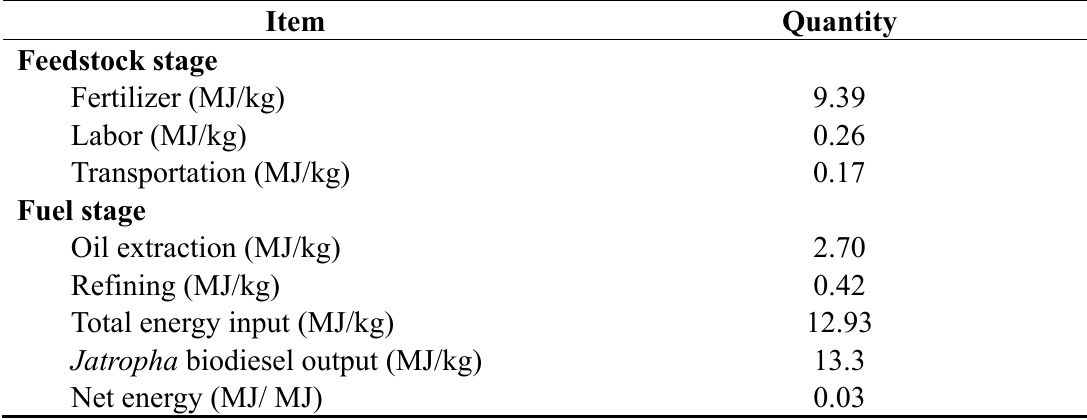
Table 2. Energy input and net energy yield of Jatropha biodiesel production.